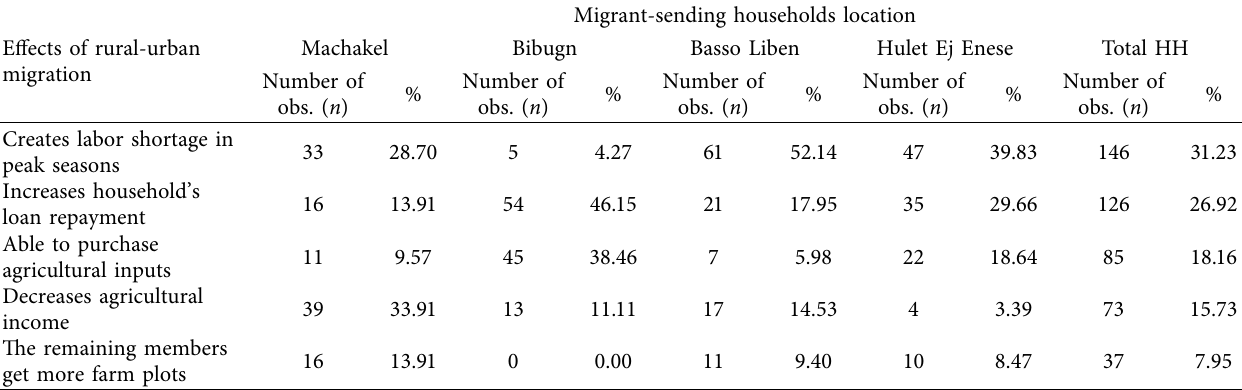
Table 3: Effects of rural-urban migration on migrant-sending households.